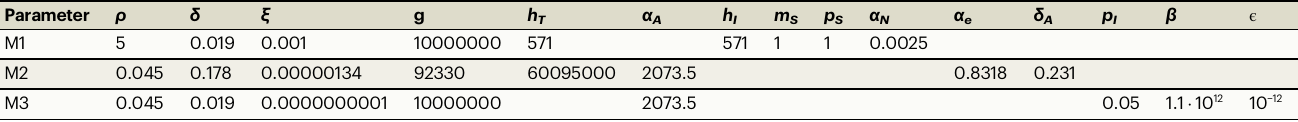
Table 2 | Fixed parameter values used in our simulations